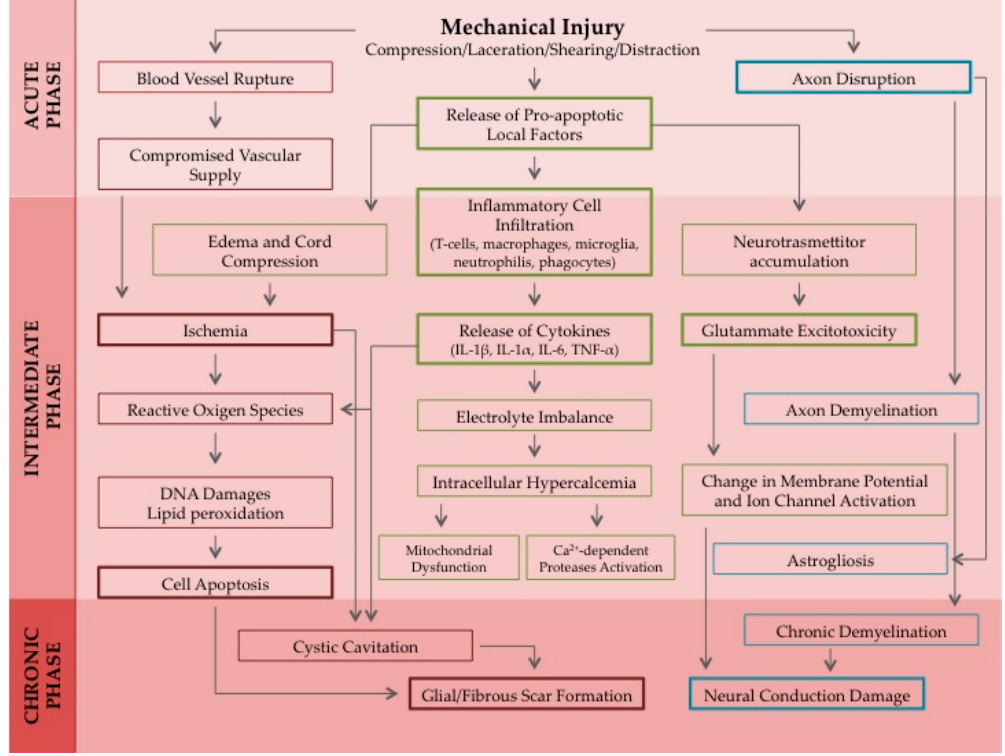
Figure 1. Schematic representation of the pathophysiological response to a spinal cord injury induced by a mechanical trauma. A cascade of vascular, cellular, and biochemical events brings to the progression of the spinal cord damage until the formation of a glial scar. Acronyms: IL-1 α , Interleukin 1 α ; IL-1 β , Interleukin 1 β ; IL-6, Interleukin 6; TNF- α , Tumor Necrosis Factor α . Axon distal segment, unconnected with the neuron soma, crushes and activates a process called Wallerian degeneration, which determines apoptosis of the oligodendrocytes surrounding distal segments [2,8]. The secondary damage ends with the formation of a glial scar, which can further impede axonal regeneration.